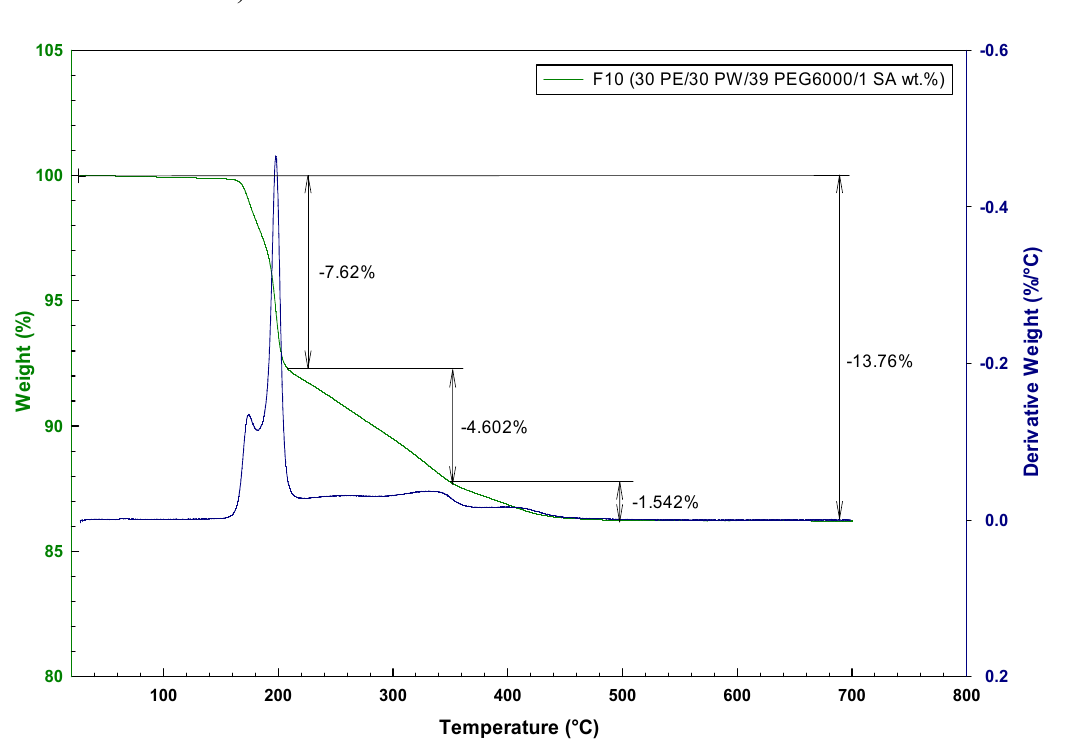
Figure 1. TGA weight loss and corresponding derivative curve for F10 (30 PE/30 PW/39 PEG6000/1 SA